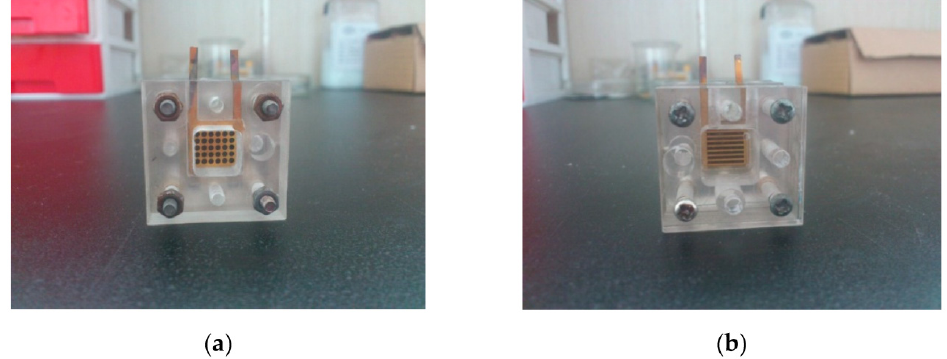
Figure 5. Pictures of the PS-DMFC assembled with trilaminar catalytic layered from ( a ) the cathode and ( b ) the anode side. Reproduced from [104].